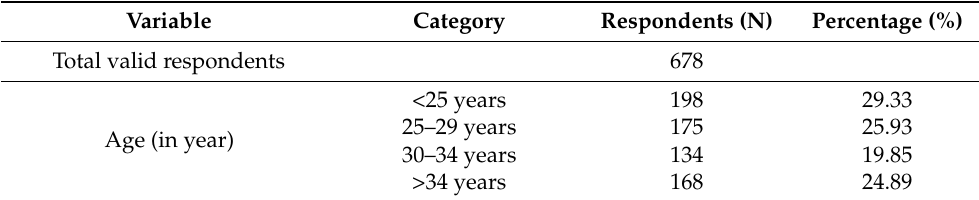
Table 3. Respondent distribution based on background